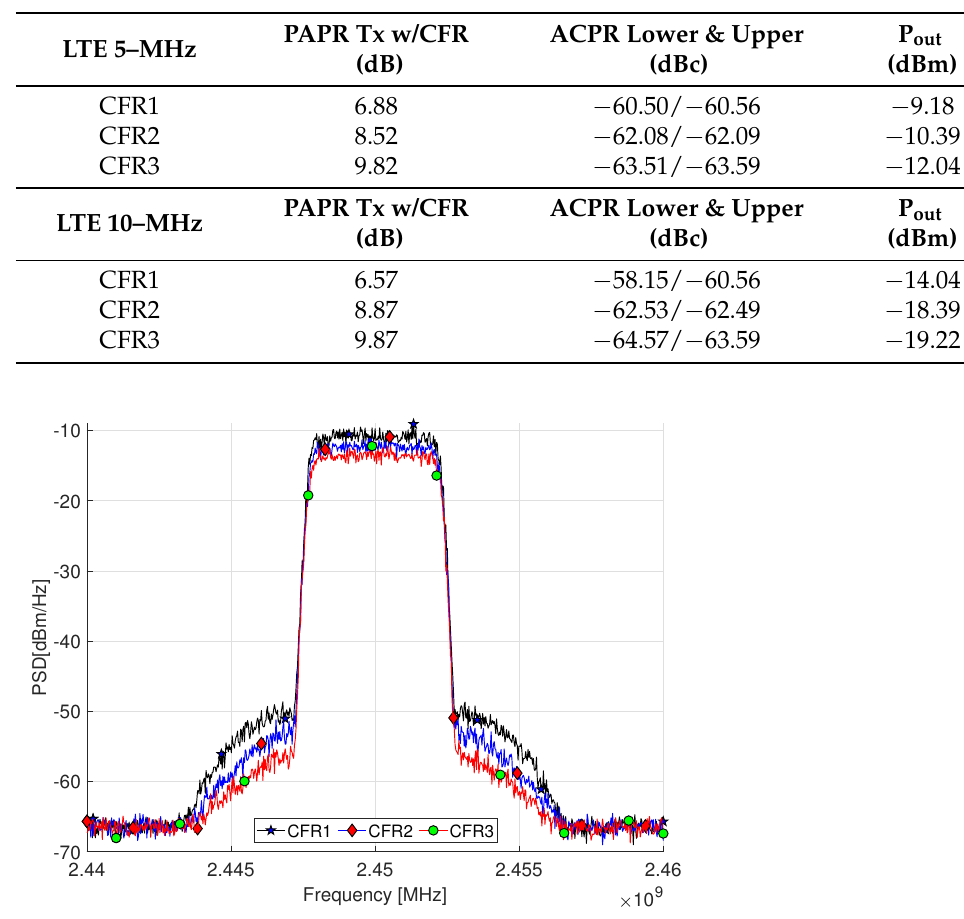
Table 2. PSD signal results after applying three CFR factors for the LTE–5 and LTE 10–MHz.